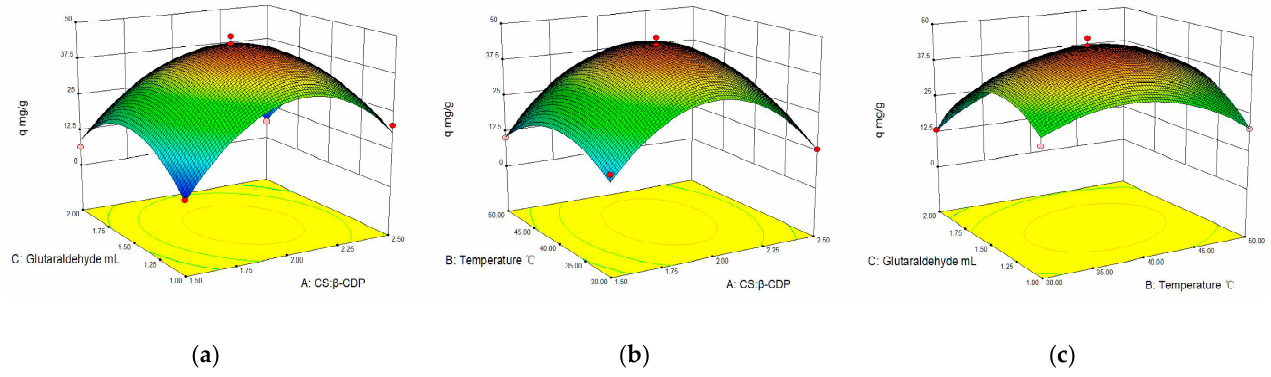
Figure 2. Effects of interaction of various factors on BSA adsorption: ( a ) glutaraldehyde addition and temperature; ( b ) glutaraldehyde addition and mass ratio of β -CDP and CS; and ( c ) mass of β -CDP and CS ratio and temperature.